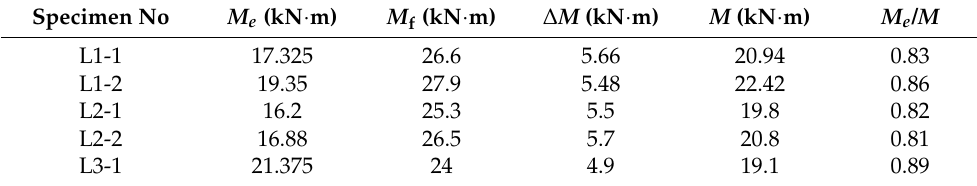
Table 8. Comparison of elastic ultimate theoretical bending moment values with test values.